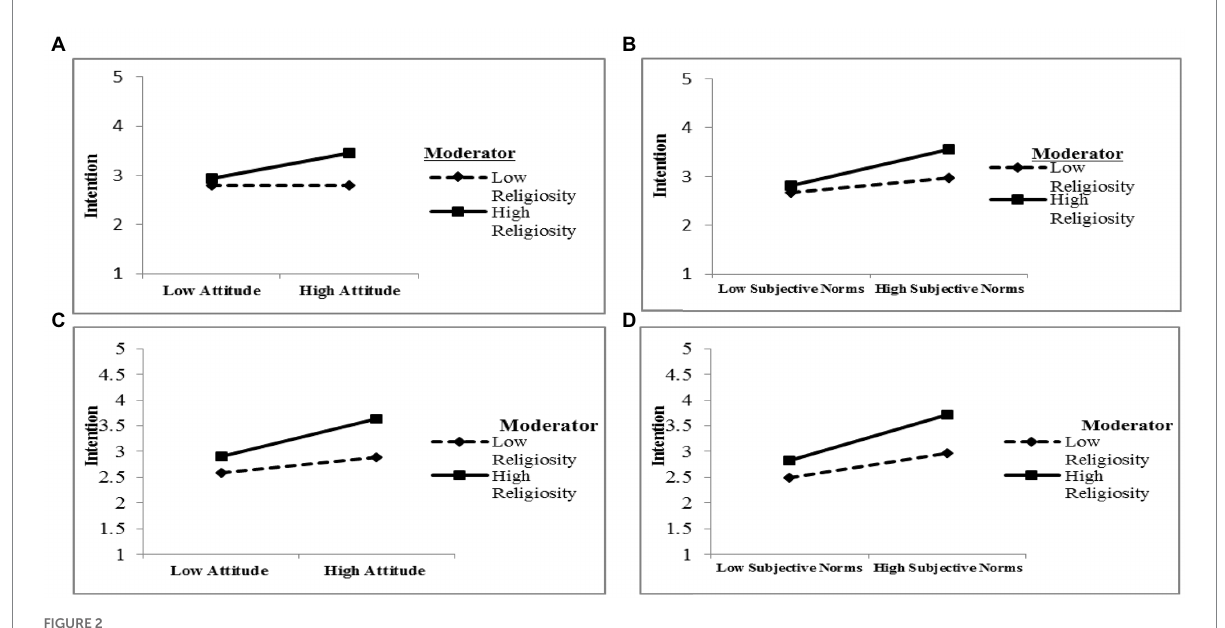
FIGURE 2 Moderator Interactions i.e. Religiosity x Attitude, Religiosity x SN, Religiosity x